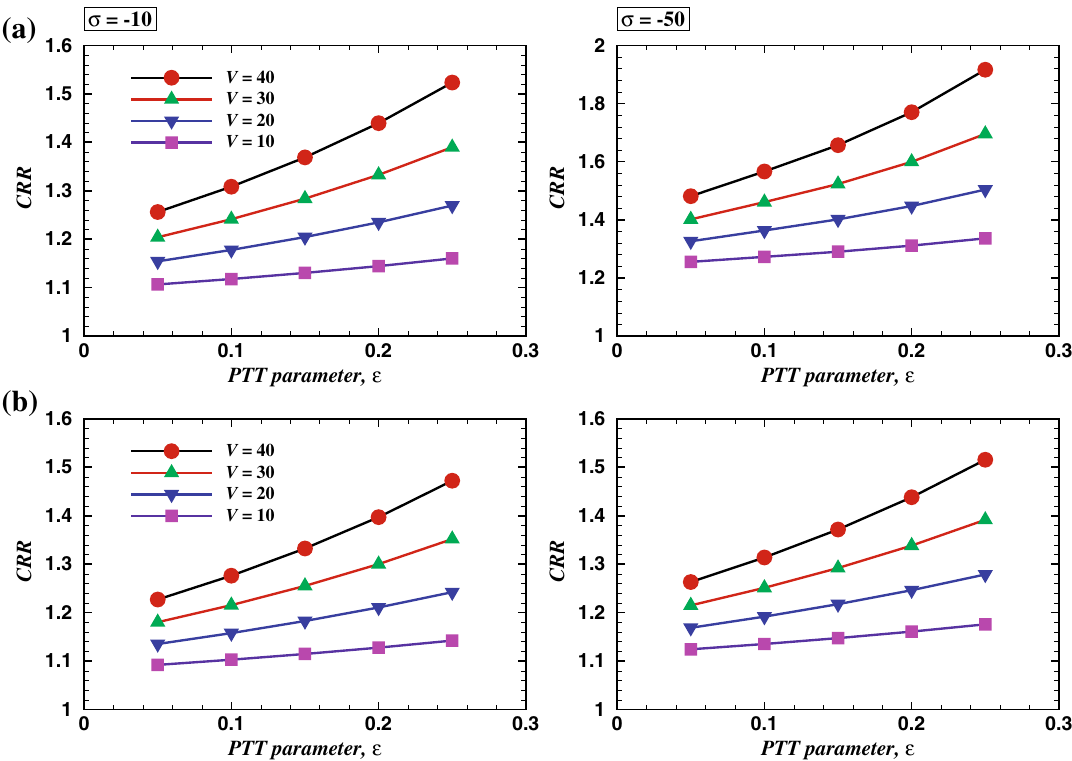
Figure 12. Variation of current rectification ratio ( CRR ) with ε for two values of σ and κ R t = 50 at ( a ) De = 1 and ( b ) De = 100 .